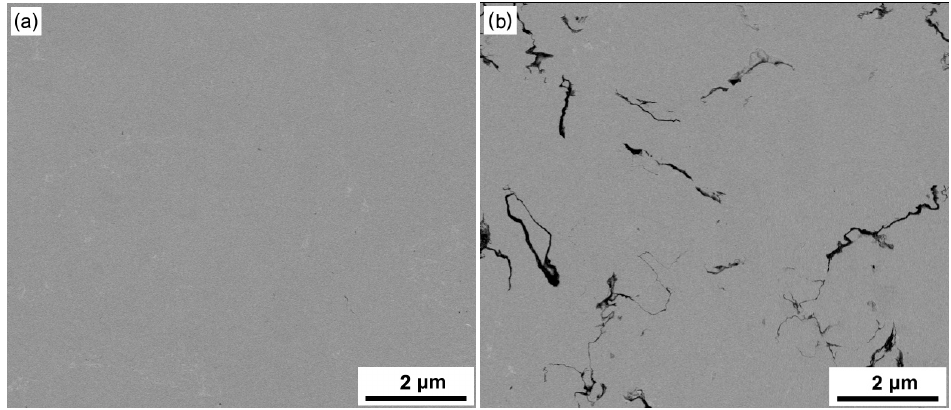
Figure 4. SEM image of the sintered ( a ) Cu 2 SnSe 3 ; ( b ) 0.75 vol % graphene/Cu 2 SnSe 3 sample.